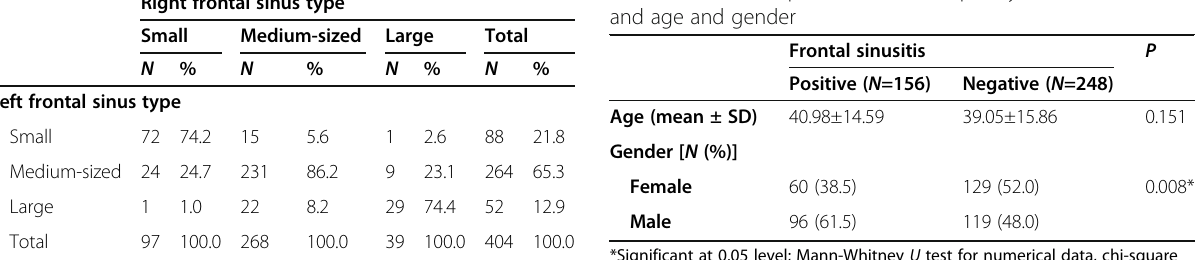
Table 2 Comparison of the right and the left sides in terms of the frequency of frontal sinus types Right frontal sinus type